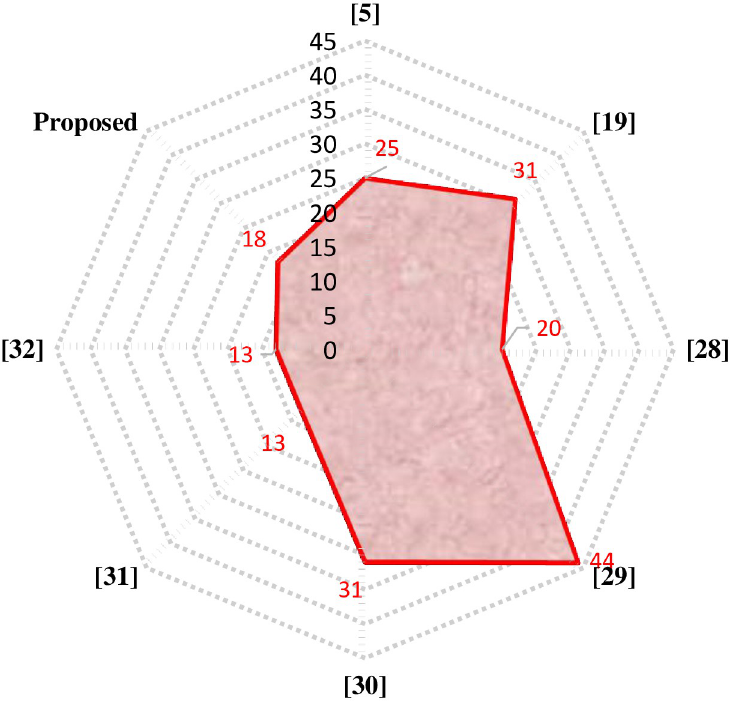
Fig 27. Comparison of 81-level MWMLI with various topologies for the number of switches as a parameter.